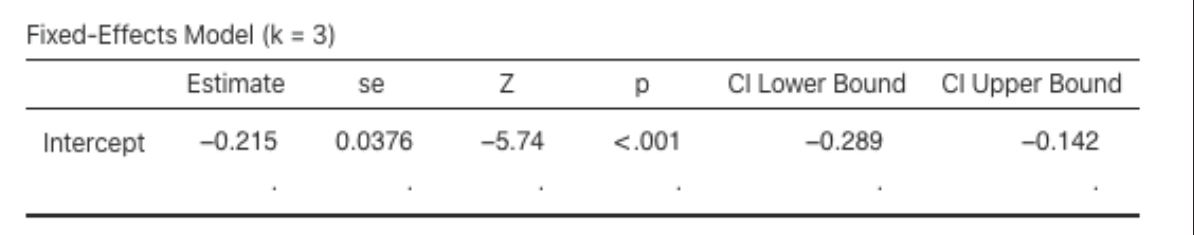
Figure 6. Pooled risk difference obtained from a fixed-effects